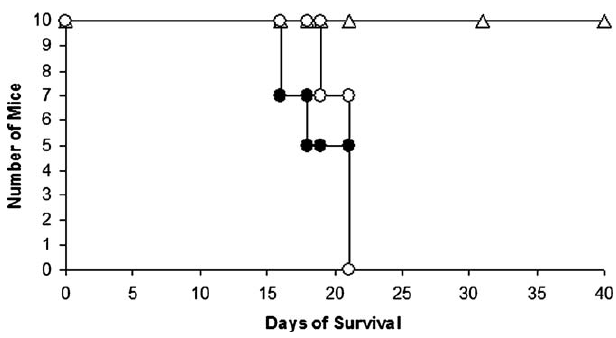
Figure 5. The cir1 Mutants Are Attenuated for Virulence Ten female A/Jcr mice were infected intranasally with the wild-type, serotype A strain H99 (filled circle [ (cid:3) ]), a serotype A cir1 mutant strain (open triangle [ D ]) or a reconstituted strain (open circle [ * ]). The survival of the mice is shown versus time in days. The assay was repeated twice with two independently generated mutants, and a representative result is shown. DOI: